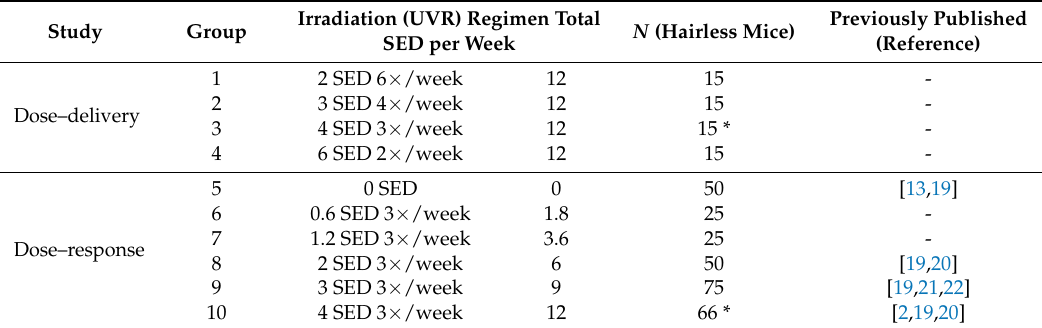
Table 1. Treatment schedule. Standard erythema dose (SED), ultraviolet radiation (UVR).